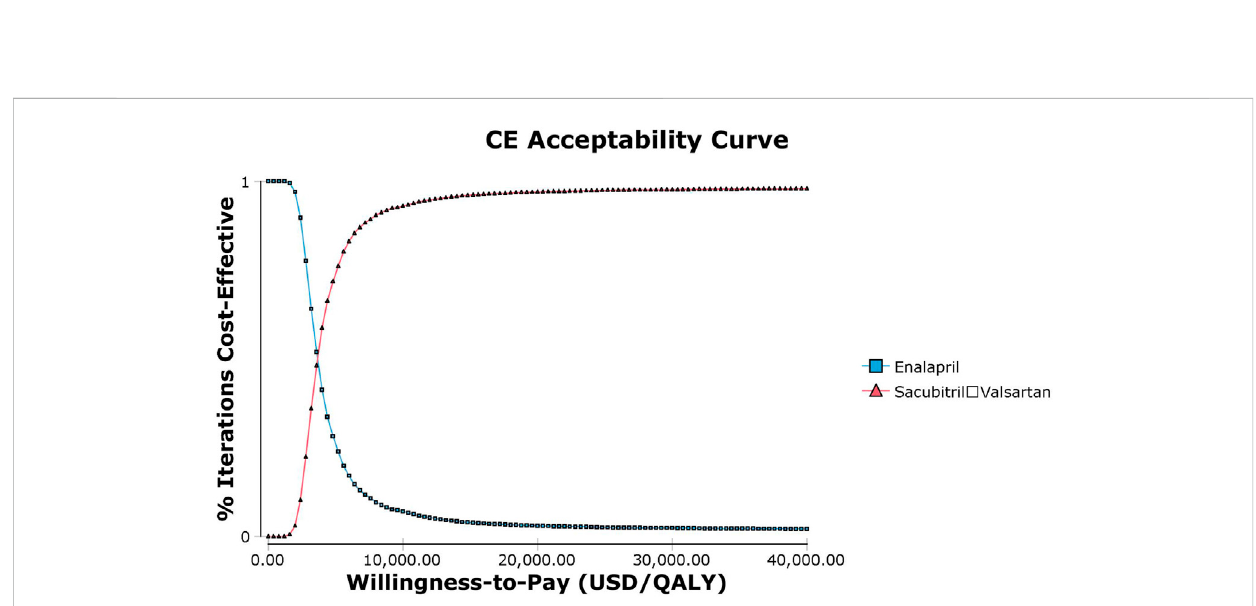
FIGURE 5 Abbreviation: CE, cost effectiveness. Cost-effectiveness acceptability curve of sacubitril – valsartan versus enalapril in acute decompensated heart failure in Chinese settings. When the willingness-to-pay threshold is 3,681.3 USD/QALY (0.293 times the per capita GDP in China in 2021), sacubitril – valsartan and enalapril shared the similar